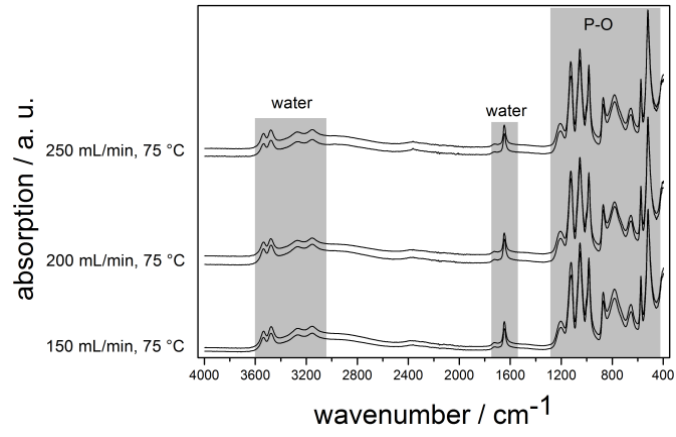
Figure 11. FT-IR spectra of the obtained materials. Absorption bands in the P-O region are observable as well as absorption bands relating to water. For each condition two spectra were shown in order to illustrate the